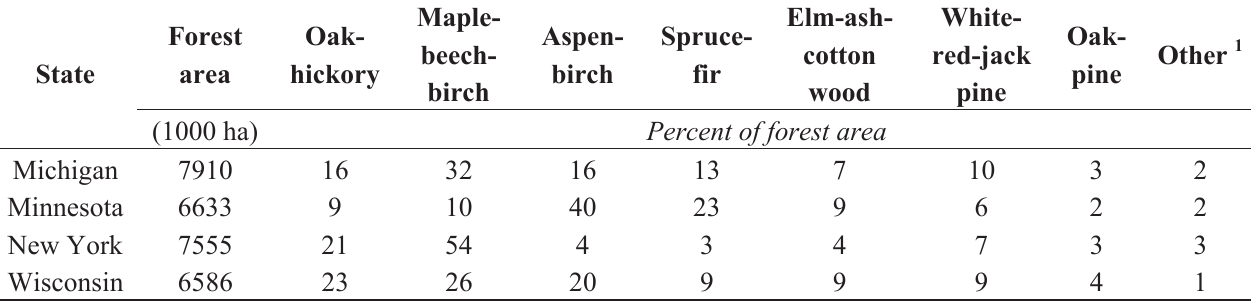
Table 1. Current forest area and percent of area by forest type for Michigan, Minnesota, New York and Wisconsin as representation of forest area and composition in the Lake States region. Data from Shifley et al. (2012)